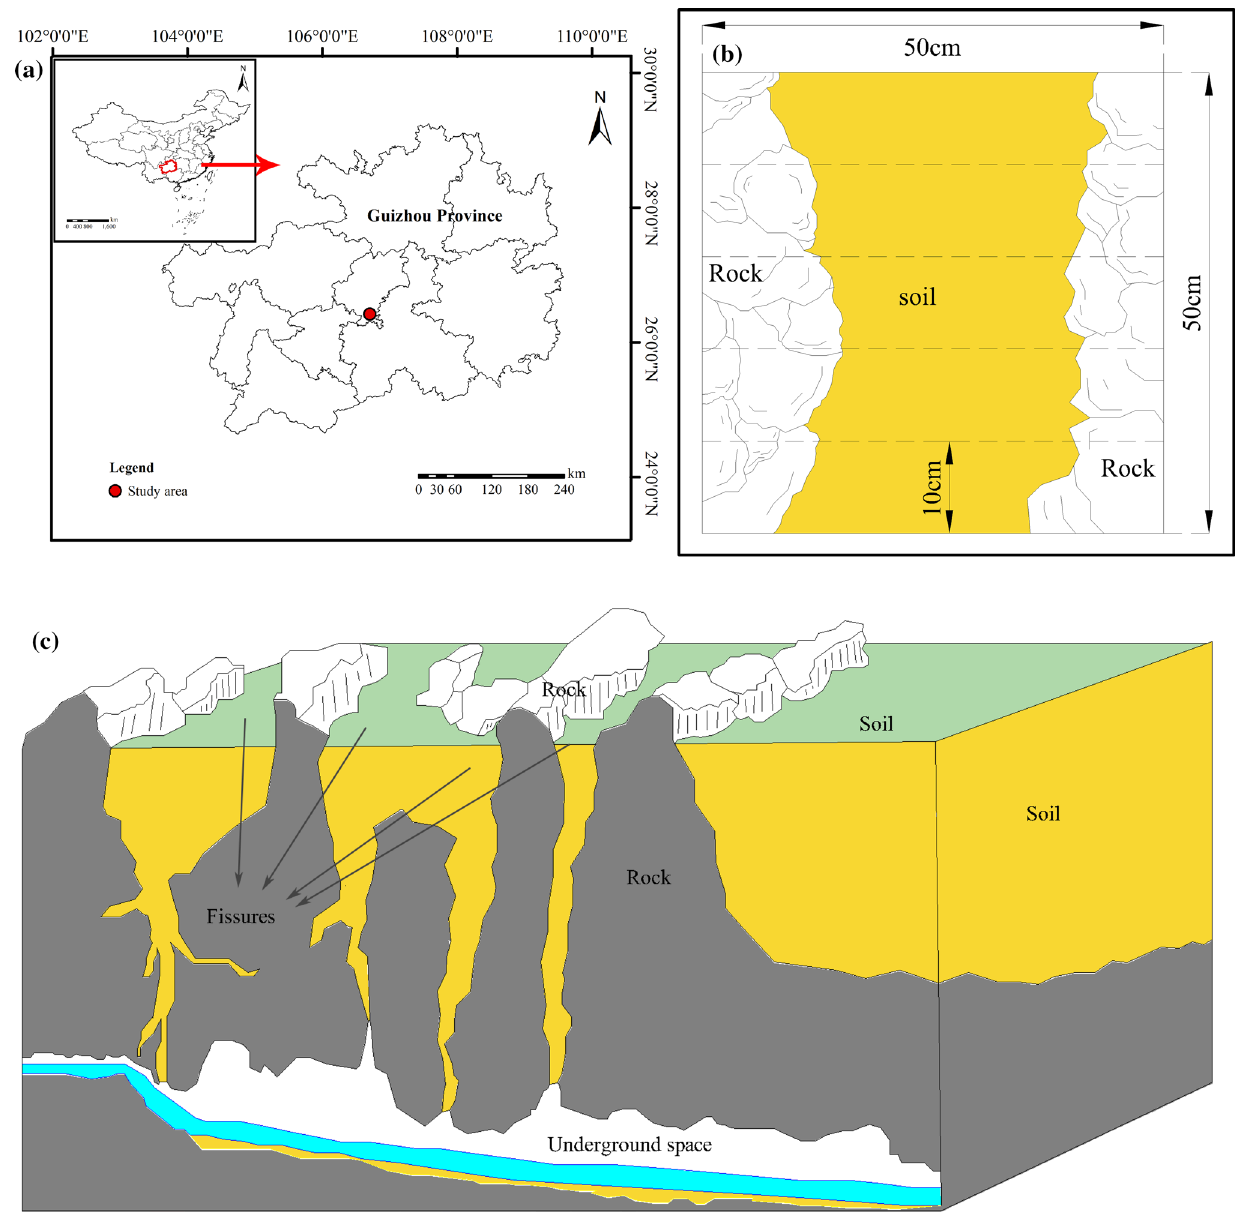
Fig. 1 Diagrammatic sketch of the dyed profile of near-surface fis- sures. a location of the study site in Guizhou province, China; b Rock–soil interface, c Different types of near-surface fissures.